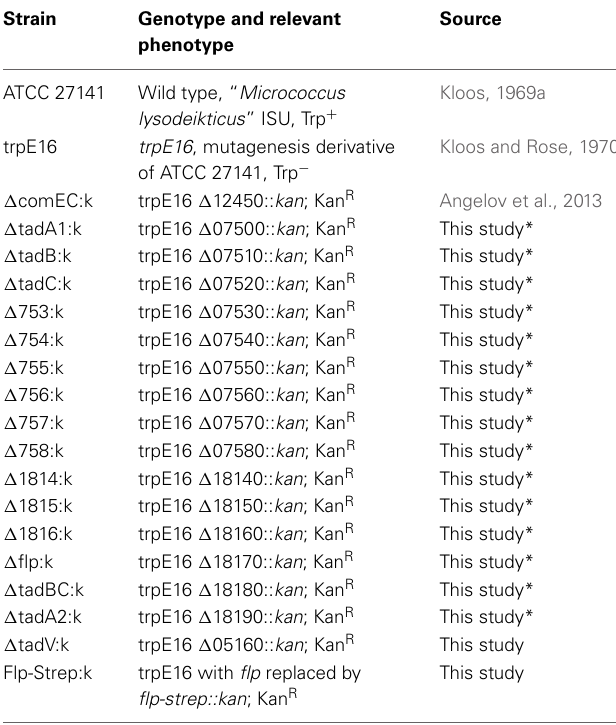
Table 3 | M. luteus strains used in this